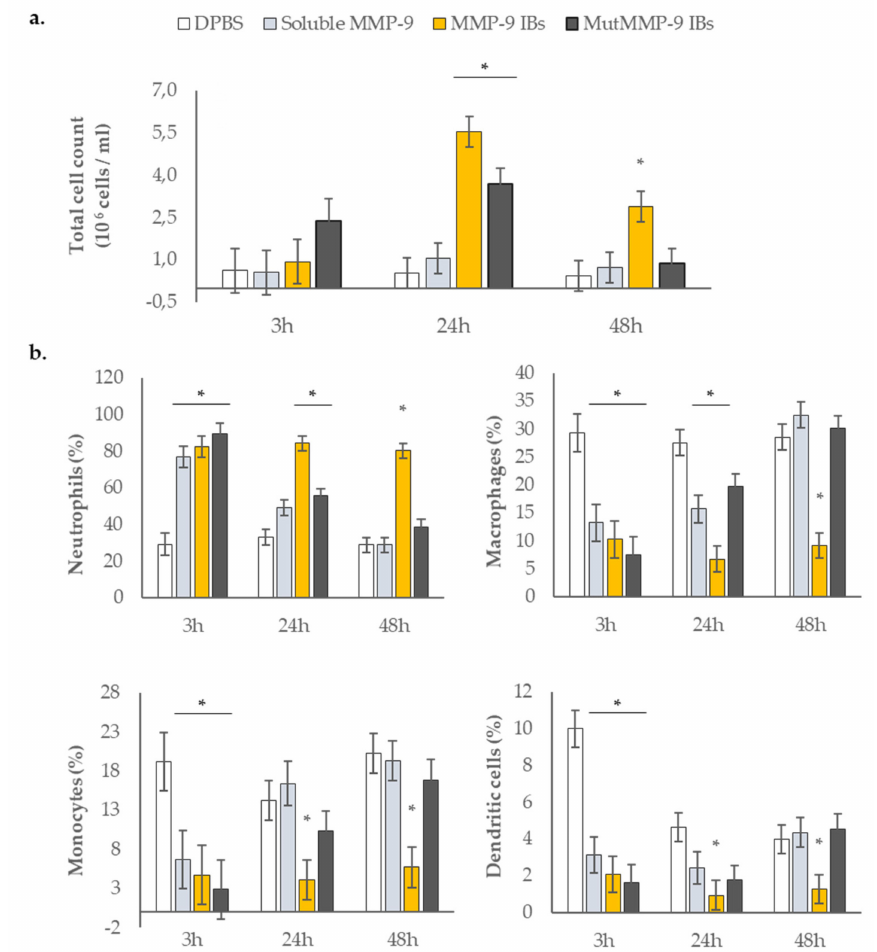
Figure 2. Cellular component analyses in the recovered exudates of the air pouches. ( a ) Total cell counts at 3, 24, and 48 h after injections with the four di ff erent treatments. Means and SEM (error bars) from non-transformed data are represented. Asterisks depict significant di ff erences ( p < 0.005). Detailed di ff erences between treatments and time points represented by di ff erent letters can be found in Table S1 in the Supplementary Materials. ( b ) Relative quantification of the di ff erent immune cell populations analyzed by flow cytometry. Means and SEM (error bars) from non-transformed data are represented. Asterisks depict significant di ff erences ( p < 0.0001). Detailed di ff erences between treatments and time points represented by di ff erent letters can be found in Table S2 in the Supplementary